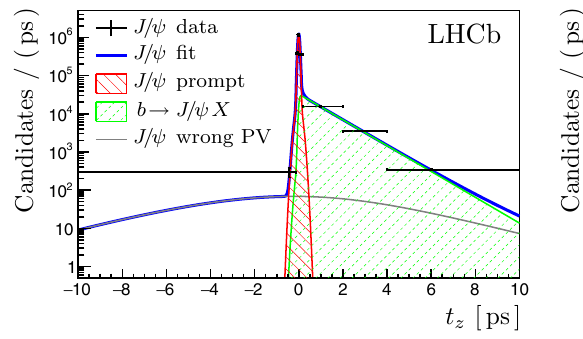
contributions from inclusive b -hadron decays, the grey lines show con- tributions from the events with wrongly associated PV. The t z values of the data points correspond to the average values of the fit function over the bins